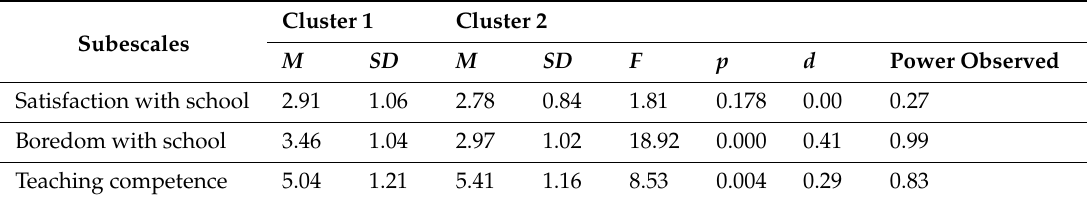
Table 5. Di ff erences in satisfaction with school and teacher competence according to cluster; multivariate analysis. Cluster 1 Cluster 2 Subescales M SD M SD F p d Power Observed Satisfaction with school